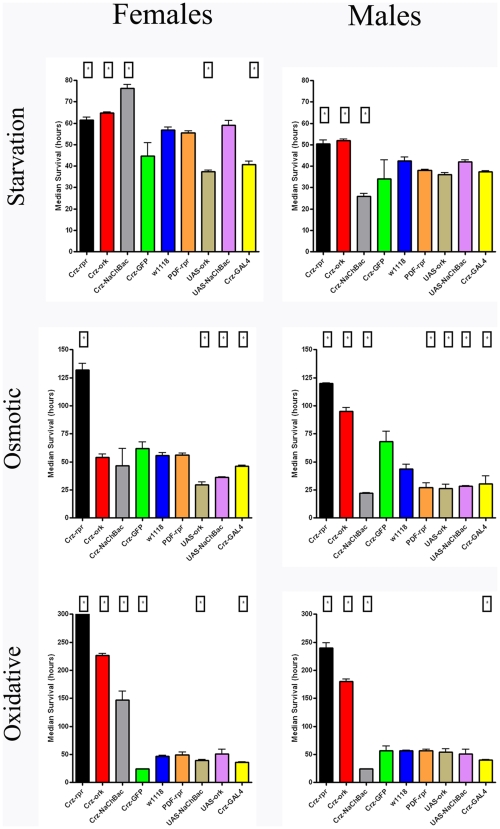
Corazonin neuronal manipulations differentially impact survival during different forms of stress.Median survival times for different genotypes subjected to three different physiological stresses. Three replicate vials of thirty individuals were assessed twice daily for survival and non-linear regression was used to estimate median survival per replicate (GraphPad Prism, San Diego). Data are mean +/− SEM from three replicates per genotype. Boxed asterisks indicate statistical difference between the background control (w1118) line (Blue bars) (ANOVA, p<0.05).